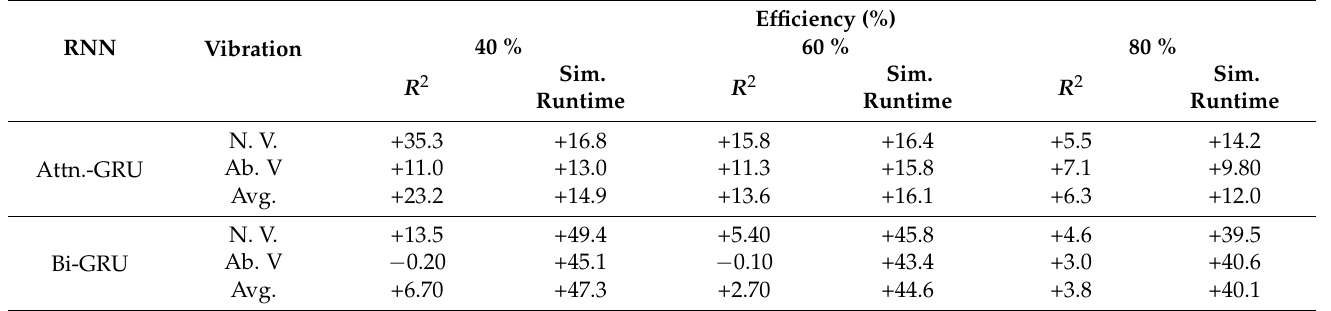
Table 7. Comparison of the rate of change between Attn.-GRU and Bi-GRU. RNN Vibration